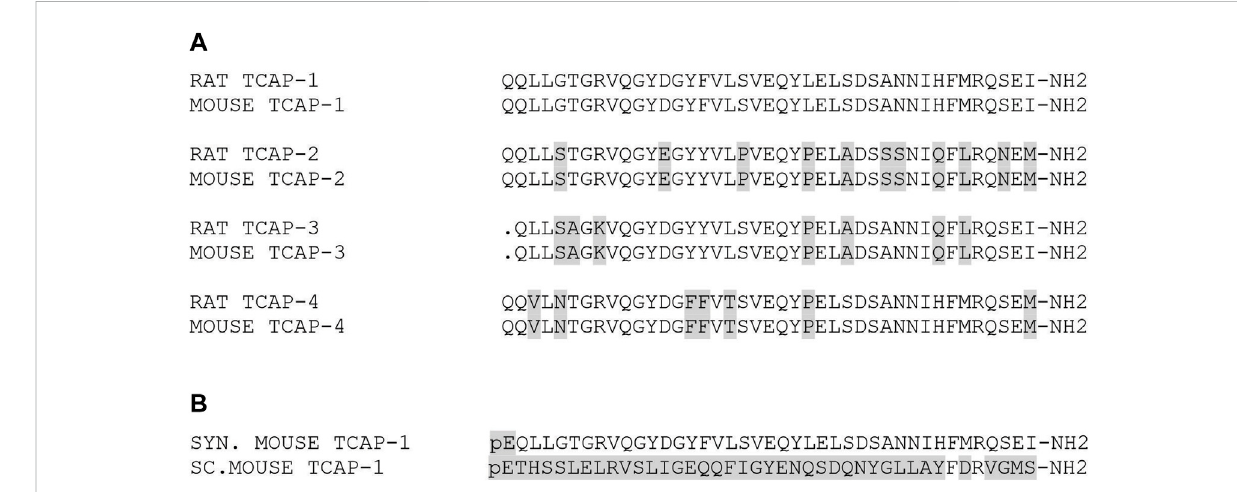
FIGURE 1 Primary structures of rat and mouse TCAP peptides. (A) . Comparison of the amino acid sequences of mouse and rat TCAPs. (B) . Primary structure ofthepeptides used inthisstudy.Grey boxed regions indicatesregionsof identityrelativeto therat/mouse TCAP isoforms.Note: pE refers to glutamine residues that have been modi fi ed to pyroglutamyl residues and – NH 2 indicates where the carboxy terminus has been expected to be modi fi ed to an amidated product. In addition, the synthetic peptides, (B) have been prepared with both modi fi cations based on their genomic